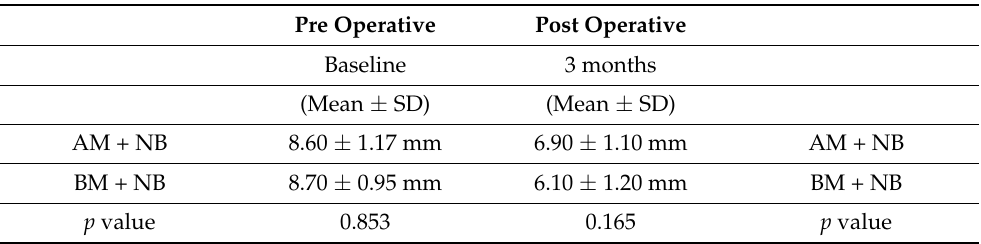
Table 1. Pocket Probing Depth (Mean [mm] ± SD) at baseline, 3 months and 6 months ( n = 10 patients in each group).